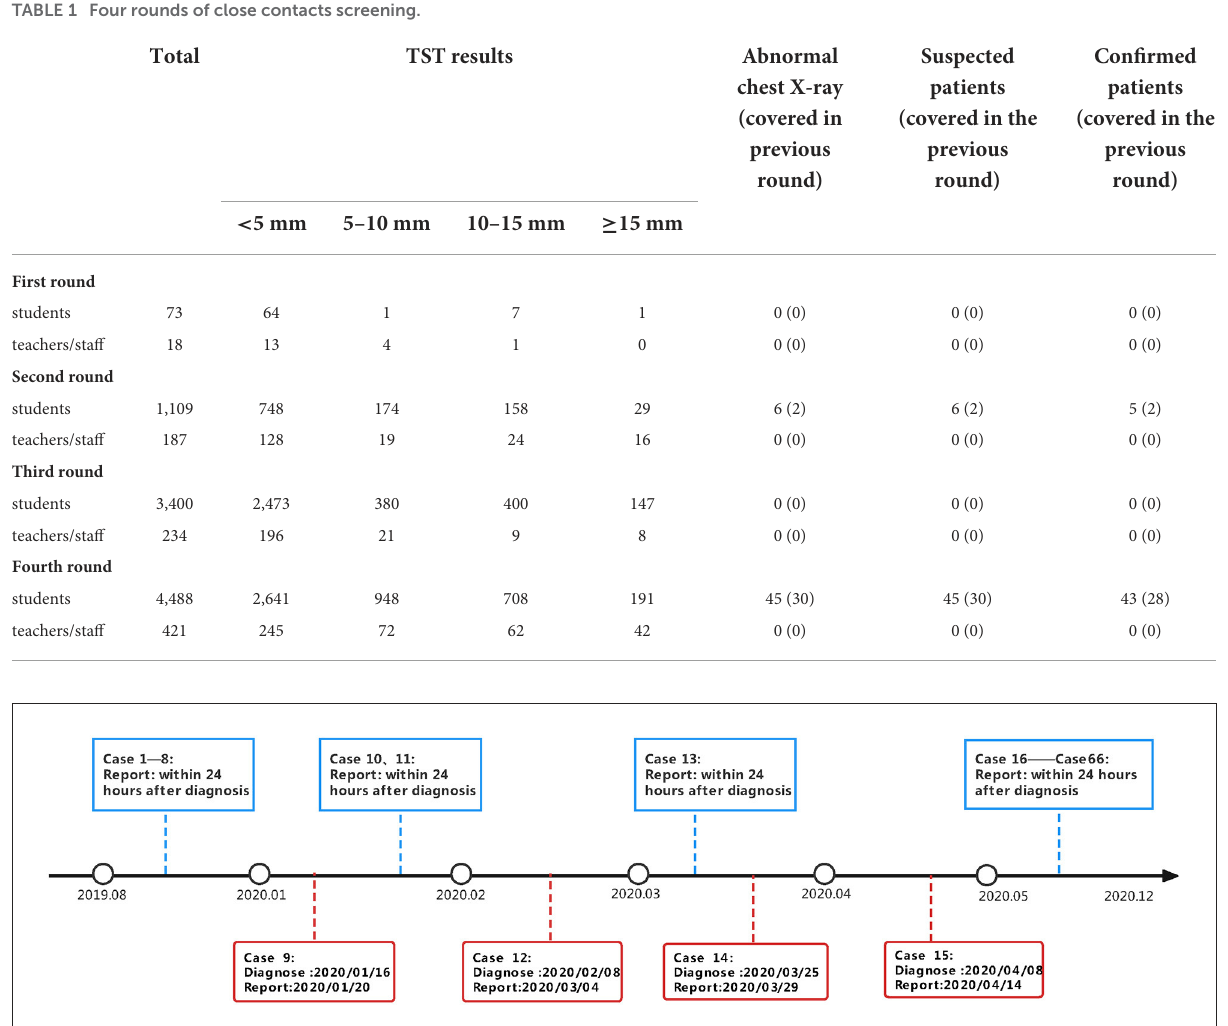
FIGURE1 Timeline of close contacts screening and case finding in a school tuberculosis outbreak